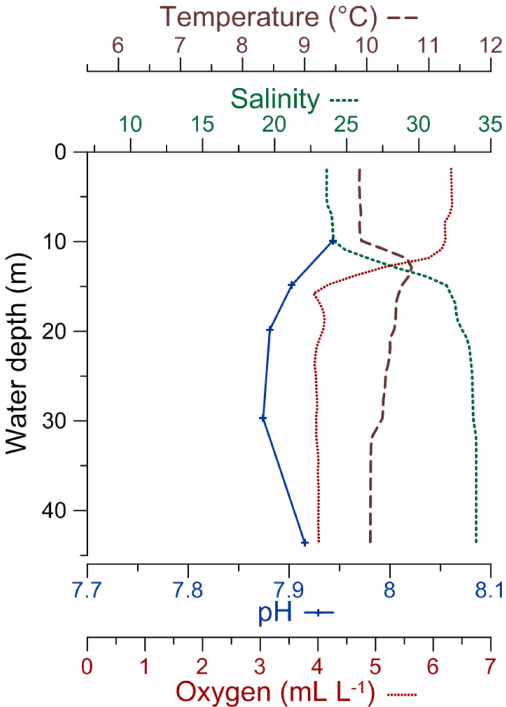
Figure 2. CTD profiles of temperature, salinity, pH, and dissolved oxygen concentration in the water column for the DV-1 station (modified from Charrieau et al.,